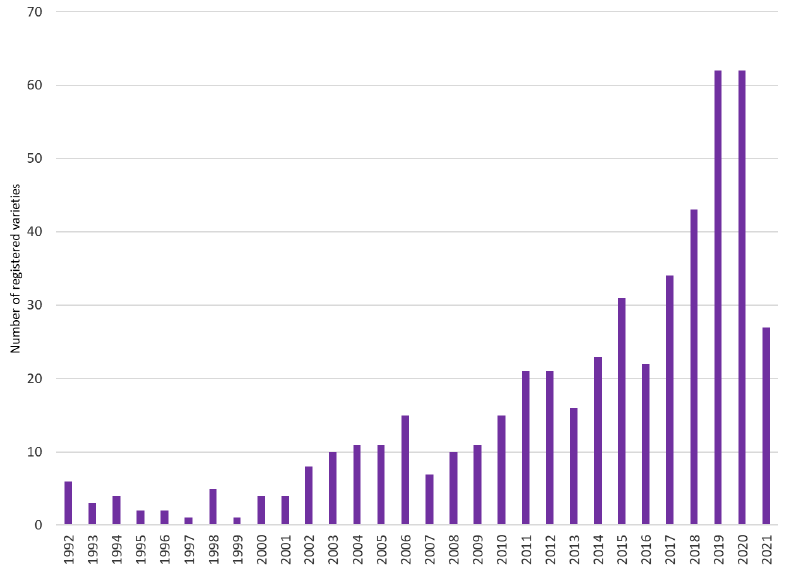
Figure 24. Number of soybean varieties according to registration year from the national variety lists of the EU member states [47–64].